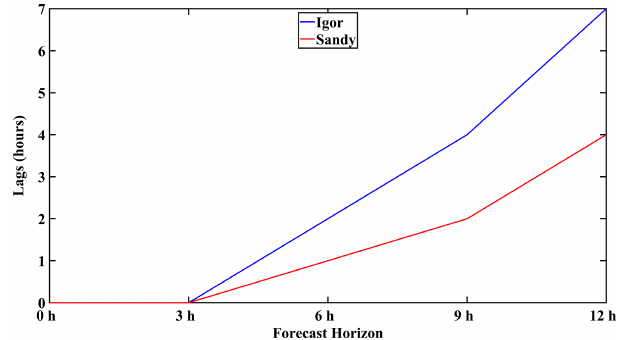
Figure 6. Estimated lags due to phase shifting of forecasted time series for Igor (blue) and Sandy